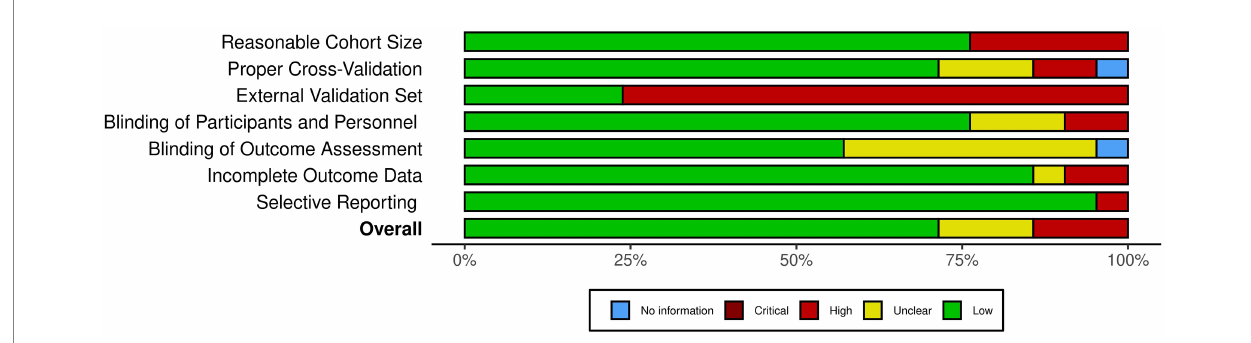
FIGURE 3 The summary of the risk of bias analysis. Each bar chart corresponds to one criteria of bias, stacked along the Y axis. The X axis quantifies the percentage of the studies with the corresponding color-coded subjective assessment as explained in the